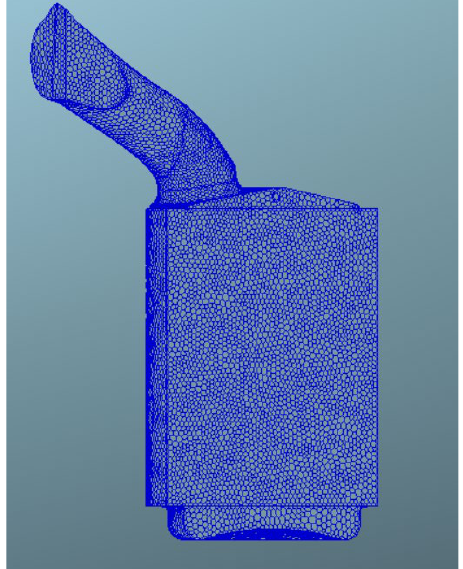
Figure 3. Engine grid.